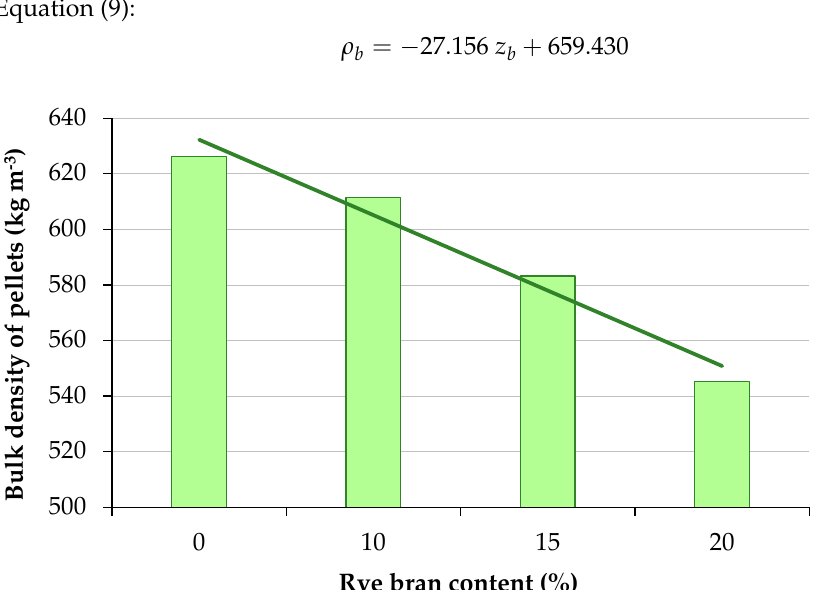
Figure 5. Bulk density of sage straw pellets with different rye bran content.